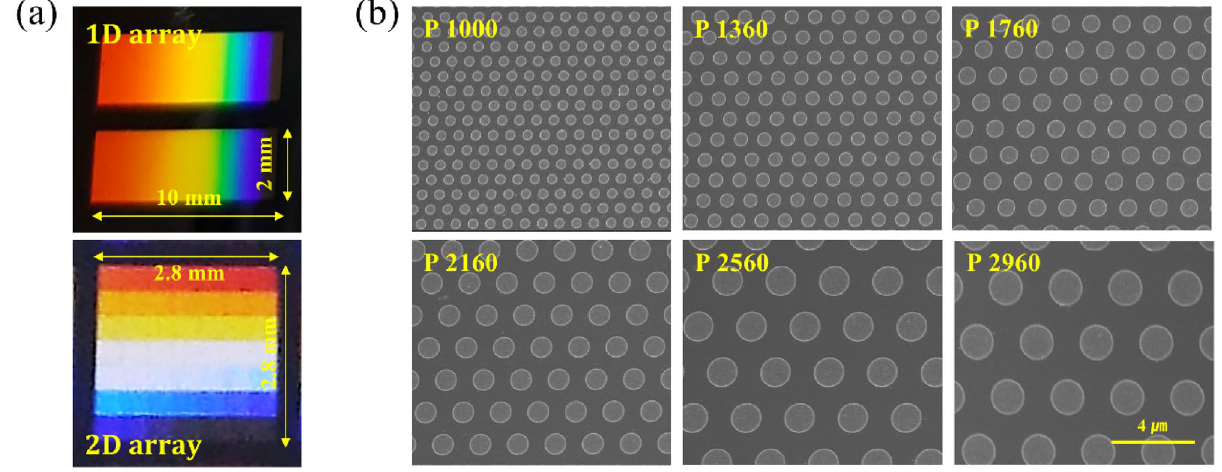
Figure 4. ( a ) The photographs of fabricated 1D (top) and 2D (bottom) filter array, and ( b ) plan-view SEM micrographs for several individual filters with different periods.